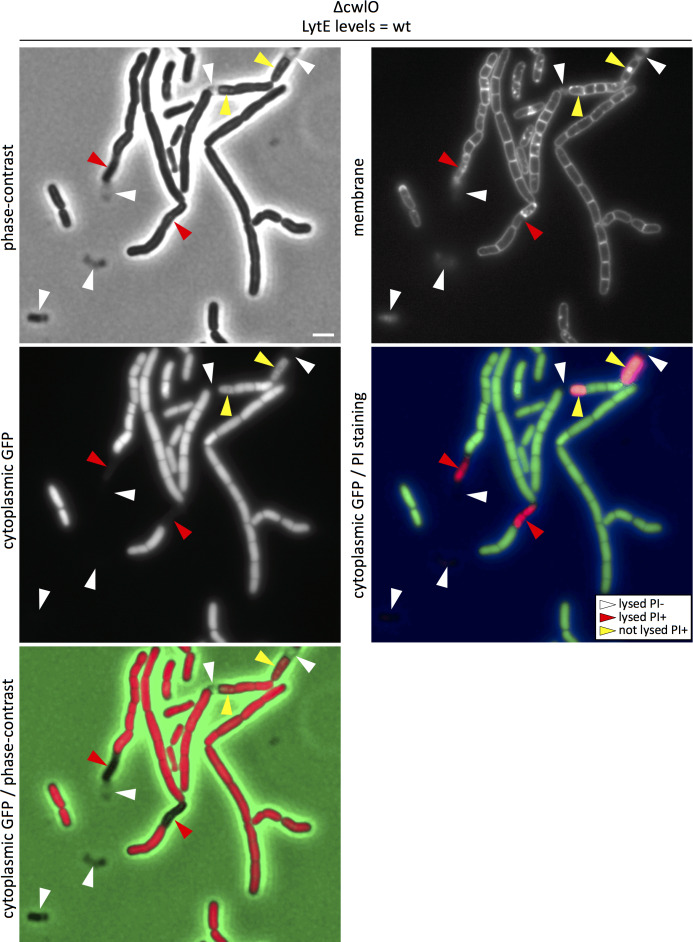
B. subtilis increases LytE levels to maintain cell envelope integrity in the absence of CwlO.Representative image of ∆cwlO ∆lytE P(IPTG)-lytE cells harboring cytoplasmic GFP and expressing lytE at wt levels (LytE levels = wt). Cells were grown to exponential phase in CH medium supplemented with 500 μM IPTG and were analyzed by fluorescence microscopy. Membranes were visualized with TMA-DPH (membrane) and propidium iodide (PI) was used as a proxy for cell envelope integrity. Overlays of cytoplasmic GFP and phase-contrast or cytoplasmic GFP and PI are shown. Red carets highlight PI-positive cells that have lysed based on loss of cytoplasmic GFP signal. White carets highlight PI-negative cells that have lysed. Yellow carets highlight PI-positive cells that have not undergone lysis based on retention of cytoplasmic GFP signal. Scale bar indicates 2 μm.